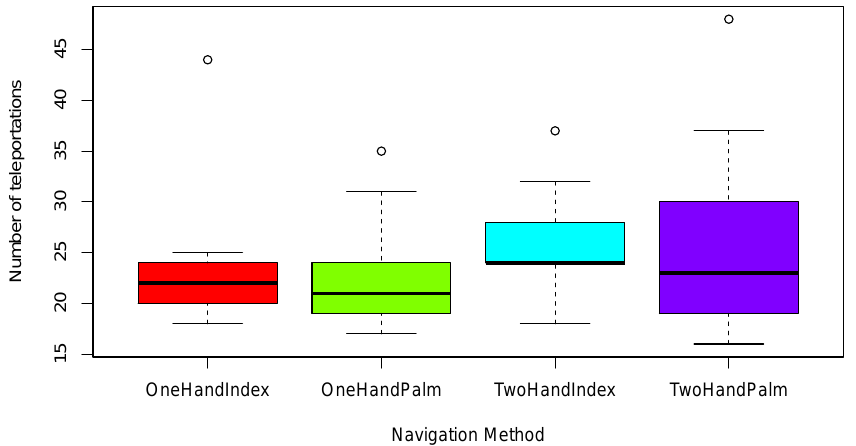
Figure 10. Boxplot for the number of teleportations required to complete the experimental task using the proposed navigation